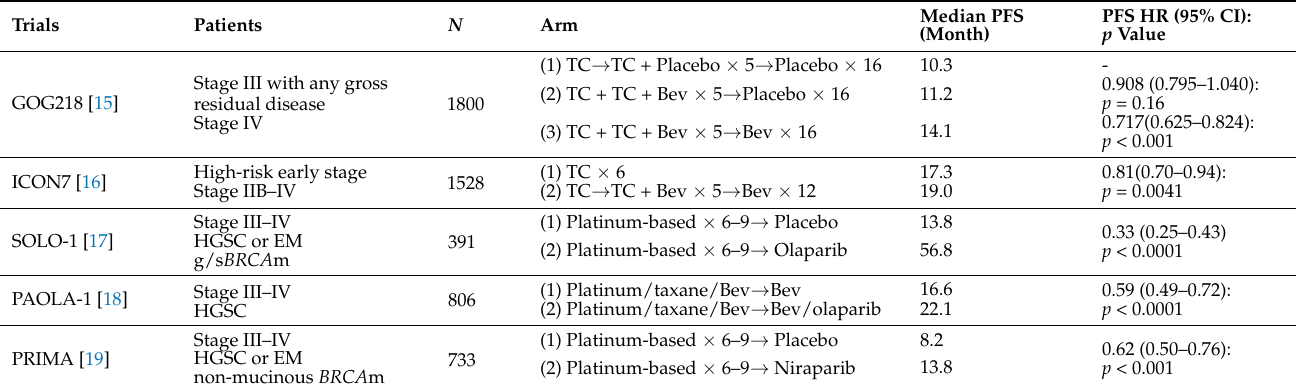
Table 3. Previous clinical trials of maintenance